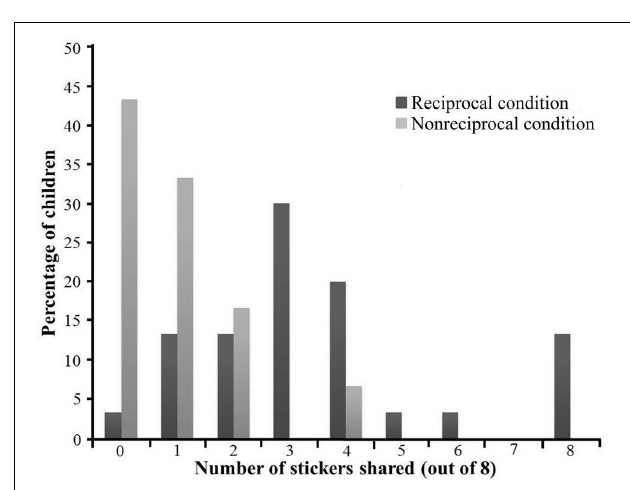
FIGURE 2 | Distribution of number of stickers shared in Experiment 1 by